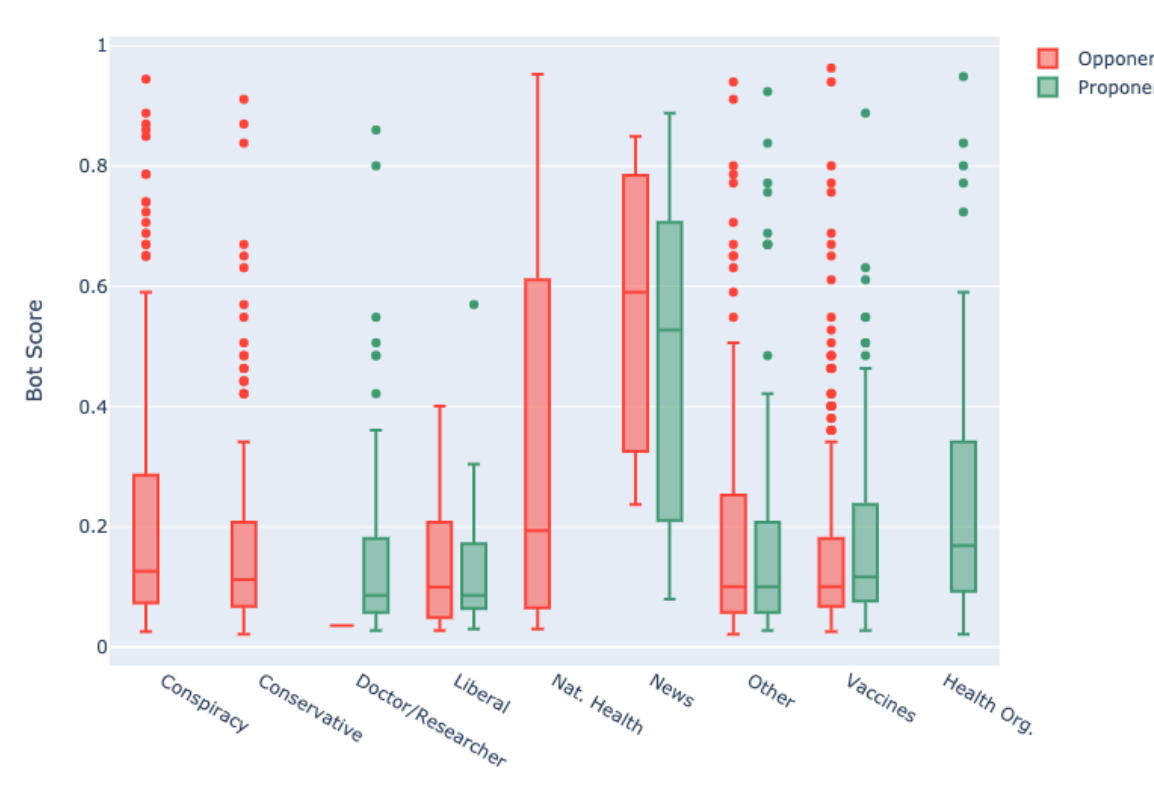
Figure 1. Retweets by subgroup. Boxplots show distribution of retweets for each subgroup, dots represent outliers. For an interactive version, please visit: https://broniatowski.github.io/Not-Just-Conspiracy-Theories/Figure%201.html Retweet counts for vaccine opponents (X 2 (7) =62.02 p<0.001) and proponents (X 2 (5)=64.12, p<0.001) both differed significantly by category using a non-parametric Kruskal-Wallis rank sum test. Among vaccine opponents, accounts that focused primarily on vaccination, and those focusing on conservative politics, had the most retweets -- both with a median of more than 100. In contrast, no accounts promoting vaccination achieved this degree of engagement. The most popular account category -- doctors/researchers -- achieved a median of 77 retweets and accounts focused primarily on vaccines were retweeted a median of 59.5